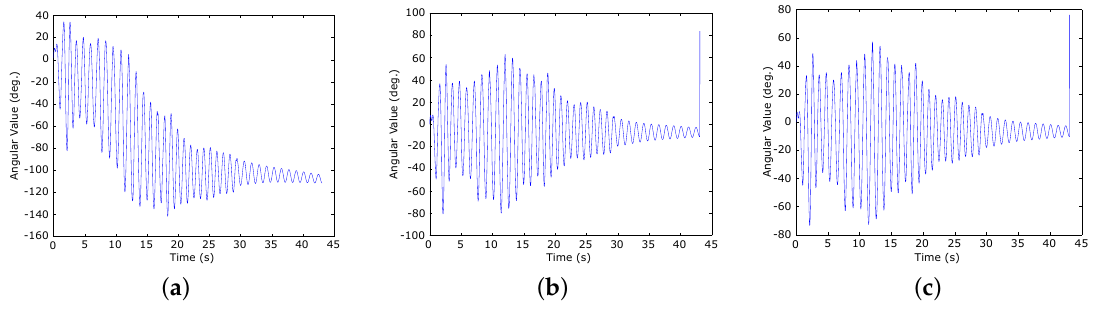
Figure 5. The Euler pitch angles calculated using a separate gyroscope sensor, our proposed solution, and the encoder. ( a ) Separate gyroscope sensor; ( b ) Our proposed solution; ( c ) The encoder.